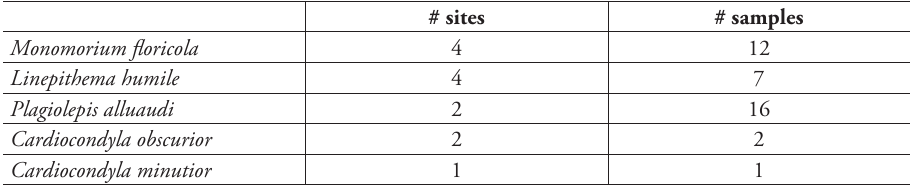
Table 3. Ants nesting in dead twig and branch samples from red mangrove, arranged in descending order of number of collection